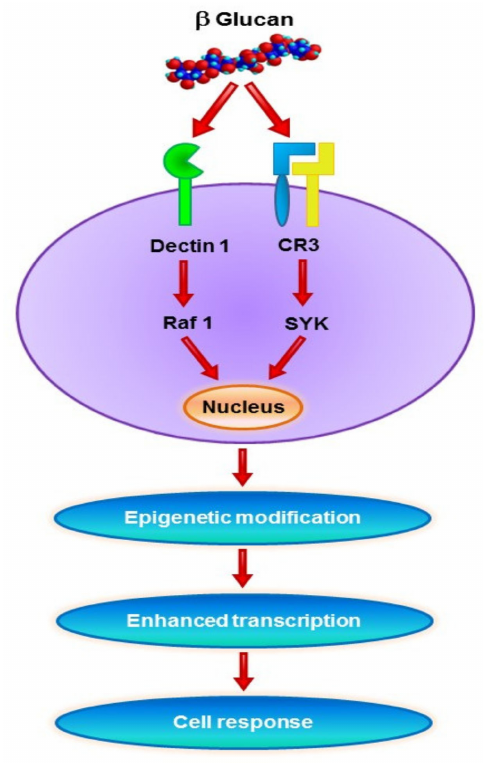
Figure 3. Potential cell signal transduction pathways involved in the generation of trained immunity. Functional reprogramming is associated with epigenetic